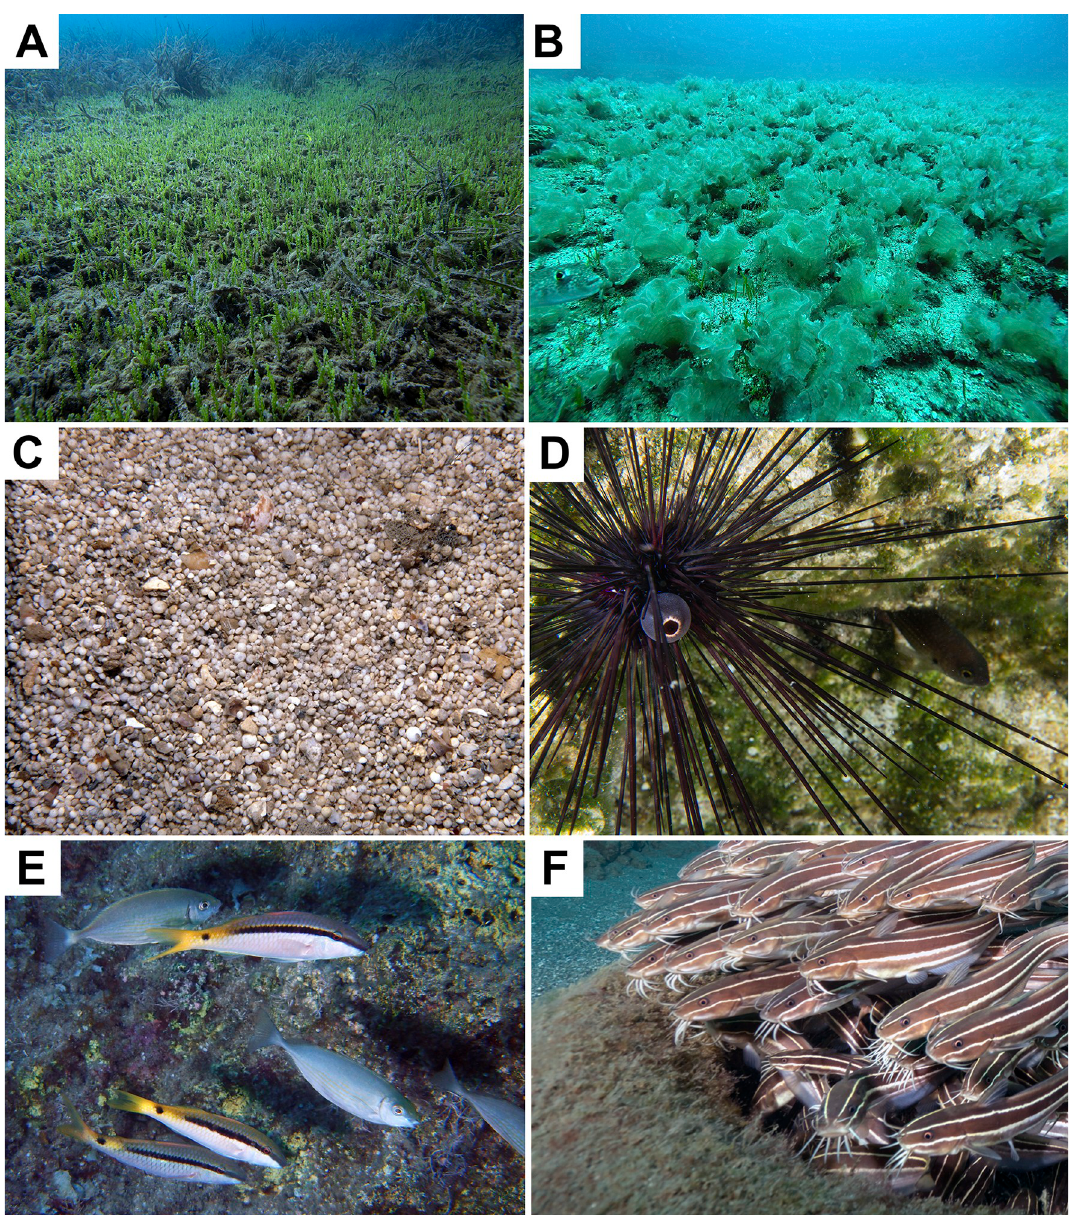
Fig 16. A— Caulerpa cylindracea observed at Ayvalık Islands Natural Park, forming dense populations at scars in the vicinity of Posidonia oceanica meadows (Photo: M.Bilecenoglu), B— Stypopodium schimperi forms dense populations at Turkish coasts (Photo: E. Ta ş kın), C—The famous “small pebble beach” at Ka ş , Antalya Bay is currently covered entirely with Amphistegina lobifera tests (Photo: M.B.Yoke ş ), D–Several coastal fish species found shelter among long spines of Diadema setosum (Photo: M.Bilecenoglu), E— The Red Sea goatfish, Parupeneus forsskali , is currently the dominant alien mullid in several localities, often observed in association with Siganus spp. (Photo: M.Bilecenoglu), F–The venomous Plotosus lineatus is a marine health hazard (Photo: B.Selli).